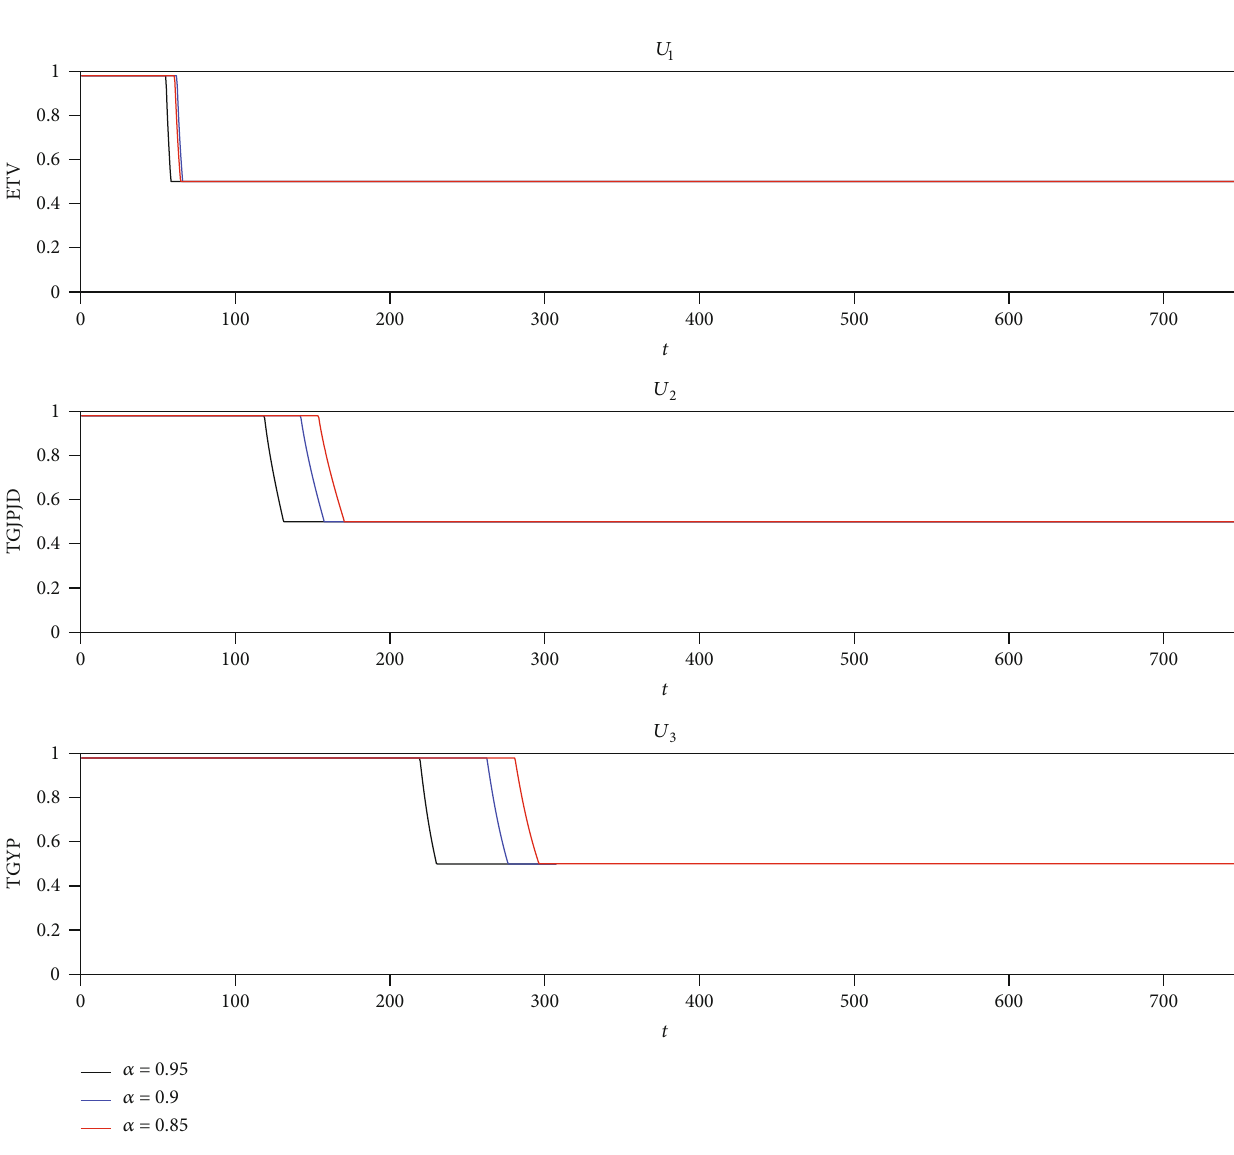
Figure 4: Optimal control strategy with ETV, TGJPJD, and TGYP and α = 0 : 95, 0 : 9, 0 : 85 . Table 3: The corresponding number of objective function of Strategy 2 with di ff erent order and control